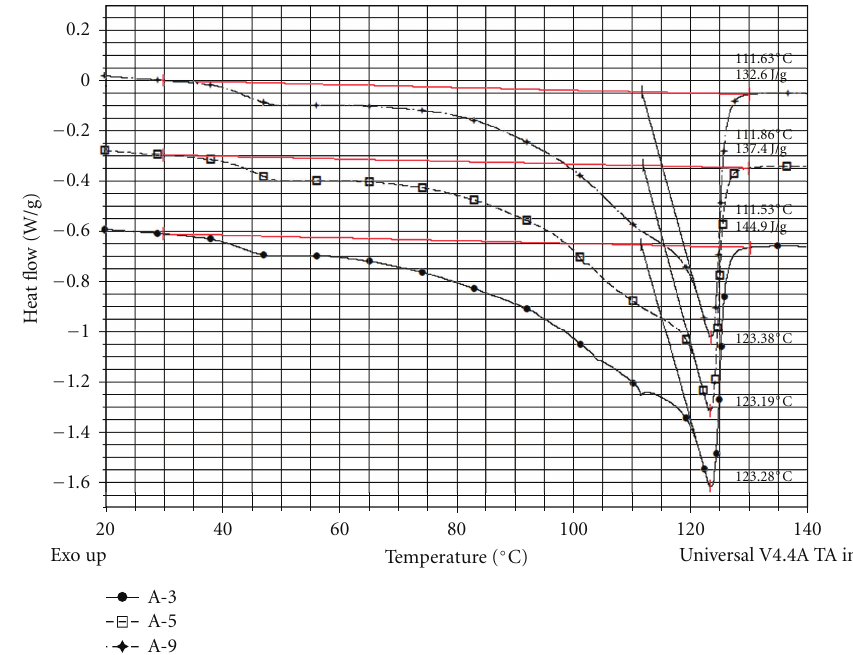
Figure 2: DSC curves for samples A-3, A-5, and A-9 at a melting stage.